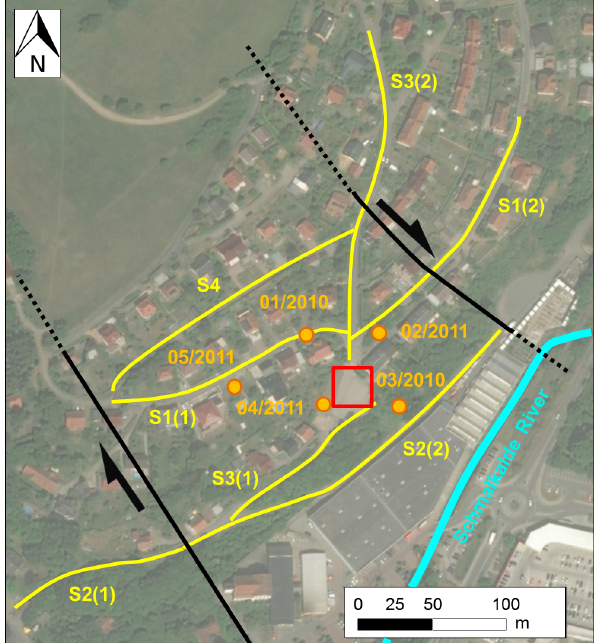
Figure 4. Location map of the S H -wave reflection-seismic profiles (yellow lines), the boreholes (orange dots), the sinkhole (red square) and the main fault branches of the Heßleser Fault zone (black lines) (ArcGIS, Open Source Map).